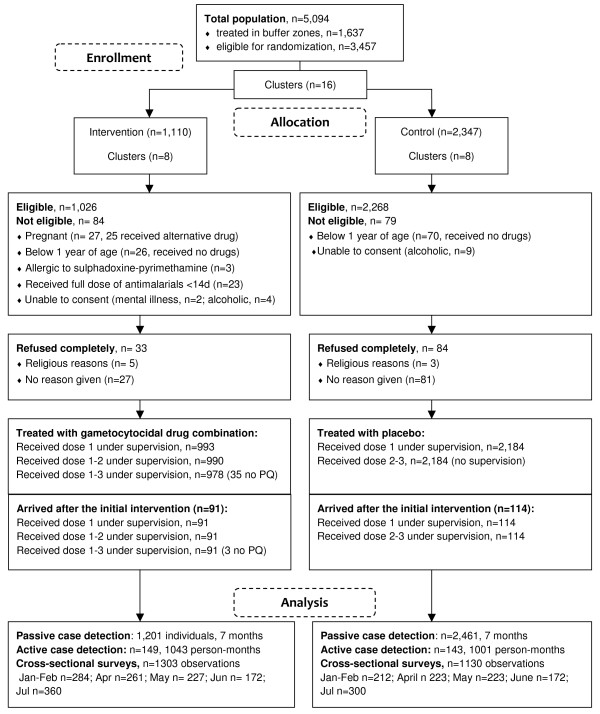
Participant flow chart.